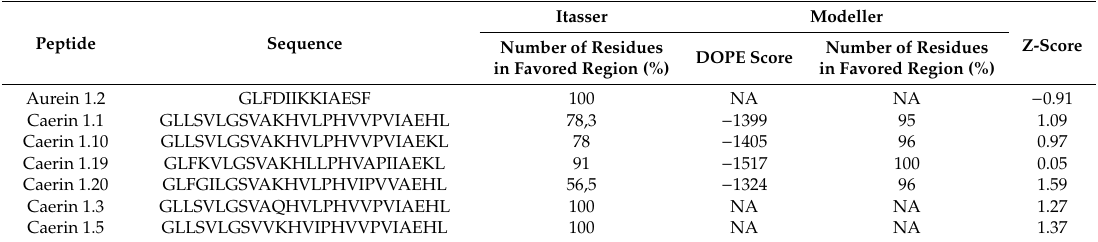
Table 3. Peptide modeling and validation structure. NA: not